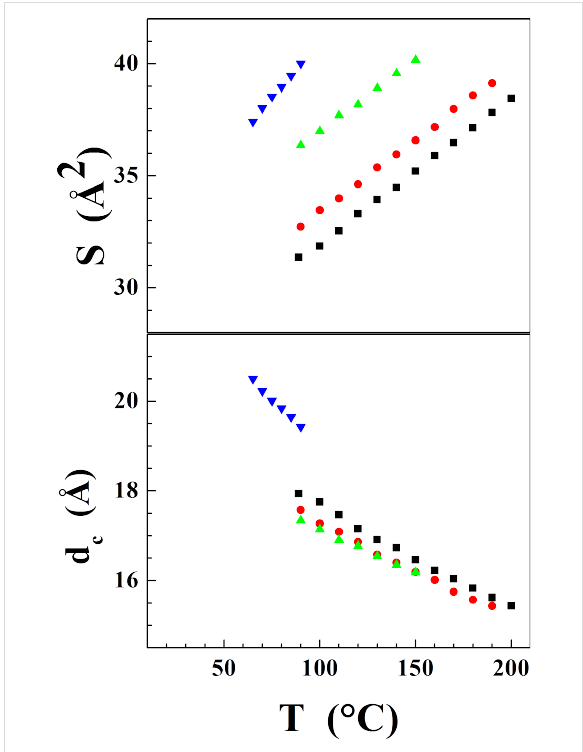
Figure 9: Variation with the counter-ion of the molecular area S and of the ionic sublayer thickness d c (including mesogenic segments) in the smectic A phase for series 1: squares: 1a (I − ); circles: 1b (BF 4− ); up triangles: 1c (PF 6− ); down triangles: 1d (CF 3 SO 3− ).